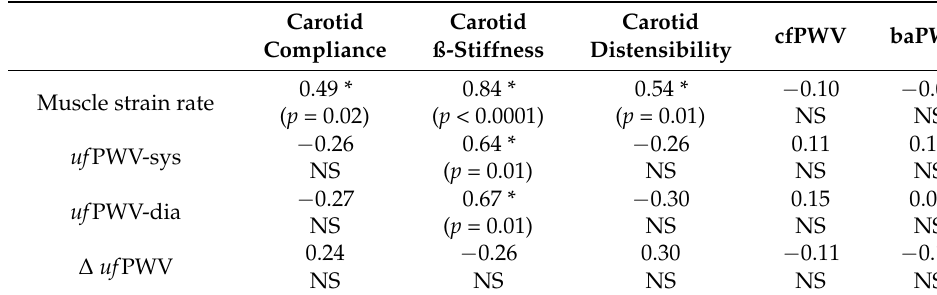
Table 3. Spearman’s correlation between muscle strain rate, carotid vascular function, and pulse wave velocity measures.